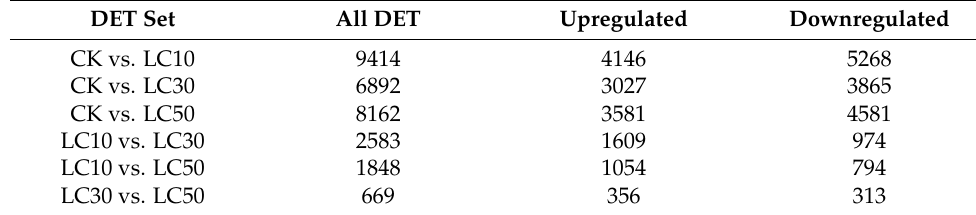
Table 2. Statistics of differentially expressed transcripts at different concentrations. DET Set All DET